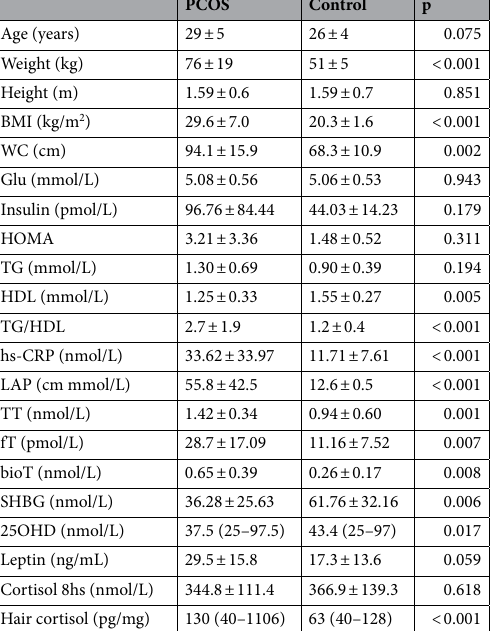
Table 1. Results are expressed as median (range) or mean ± SD according to distribution. BMI body mass index, WC waist circumference, Glu glucose, TG tryglicerides, HDL HDL cholesterol, hs-CRP high sensitive C reactive protein, LAP lipid accumulation product, TT total testosterone, fT free testosterone, bioT bioavailable testosterone, 25OHD 25-hydroxyvitamin